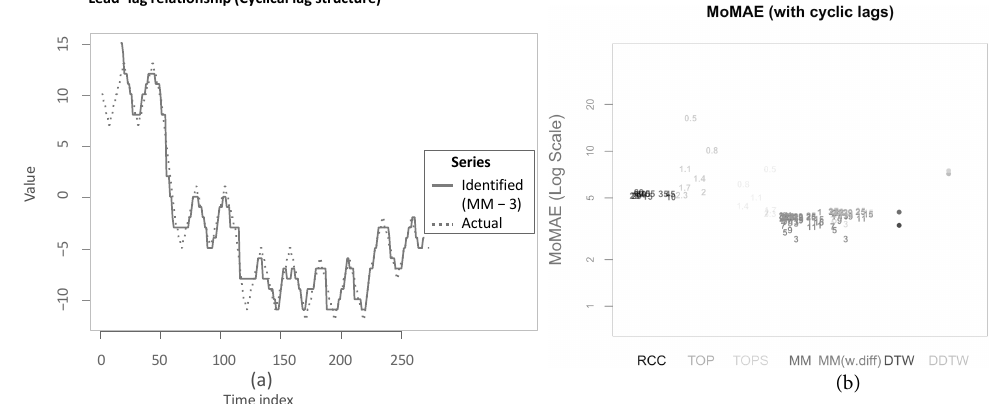
Figure 13. Robustness check towards cyclical lag structure. ( a ) lead-lag relationship with cyclical lags; ( b ) MoMAE with underlying cyclic lag structure.